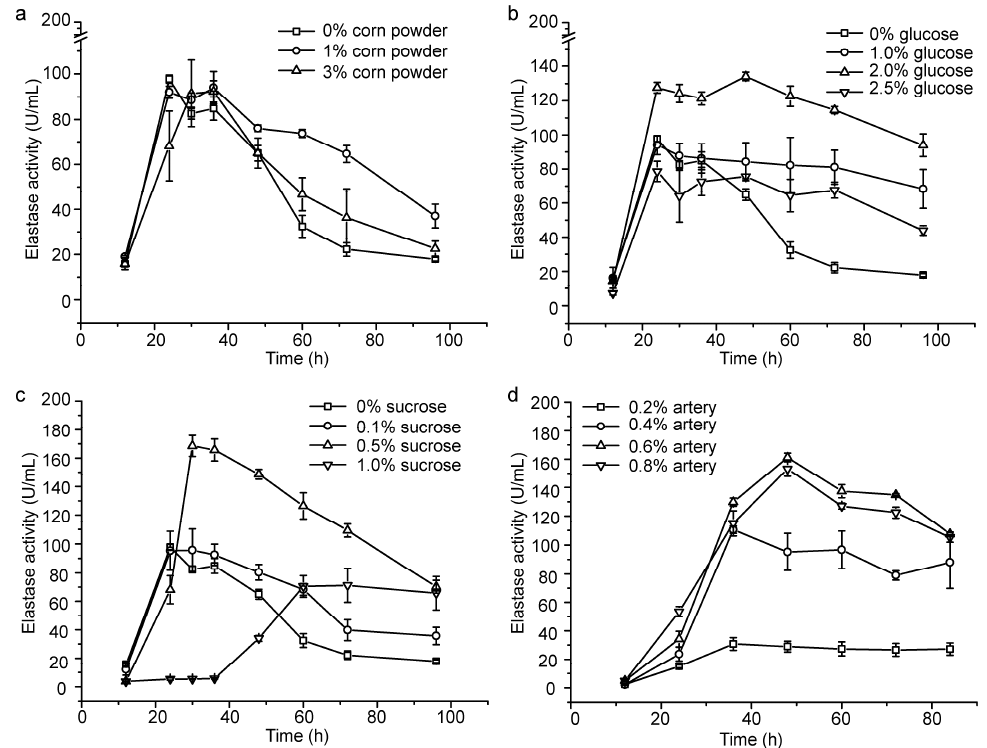
Figure 1. Optimization of the fermentation medium of CF6-2 for pseudoalterin production. ( a ) Effect of the corn powder content on pseudoalterin production; ( b ) Effect of the glucose content on pseudoalterin production; ( c ) Effect of the sucrose content on pseudoalterin production; ( d ) Effect of the artery powder content on pseudoalterin production in the basal medium, containing 0.5% sucrose as a carbon source. The graphs show data from treatments performed in triplicate (mean ± S.D.).